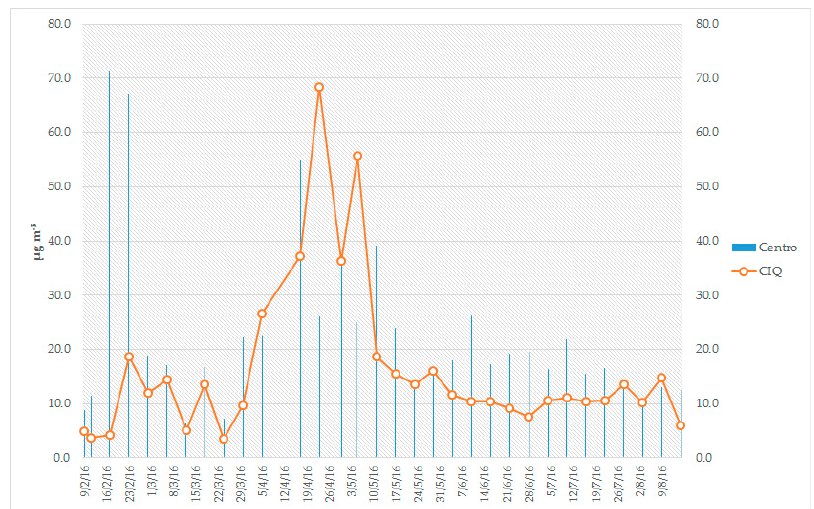
Figure 3. Time series for the concentration of PM 2.5 observed at both sites during the period studied.